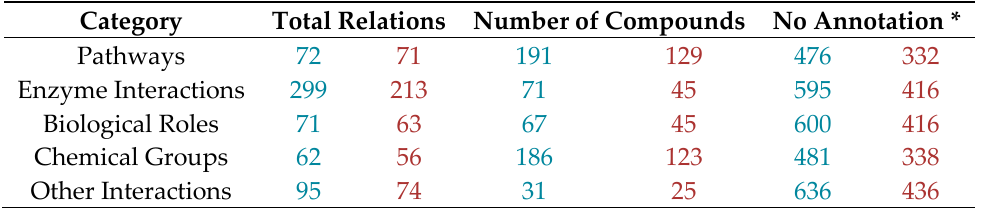
Table 2. Category distribution for metabolites detected in cellobiose (blue) and Avicel (red) growth condition. The total metabolites detected in cellobiose were 667 and in Avicel were 461.